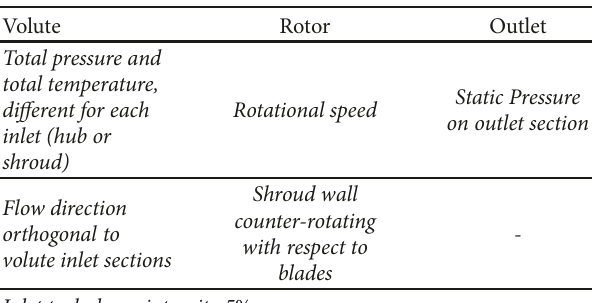
Figure 4: Rotor channel structured mesh. Table 3: Boundary